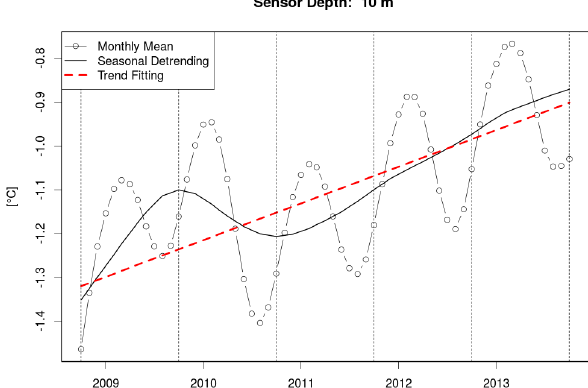
Figure 3. Methodological steps of trend analysis. Step 1: monthly aggregation (thin black line with circles). Step 2: seasonal detrend- ing (thick black line). Step 3: trend fitting (dashed red line). Vertical dashed lines represents 1 October, materializing the limits of the hydrological